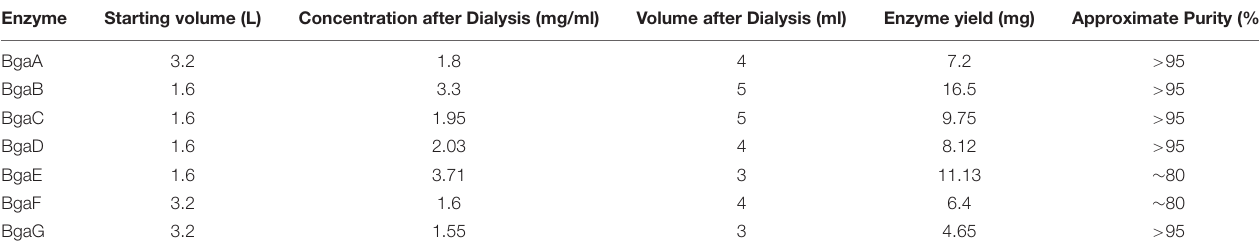
TABLE 2 | β -galactosidase purification